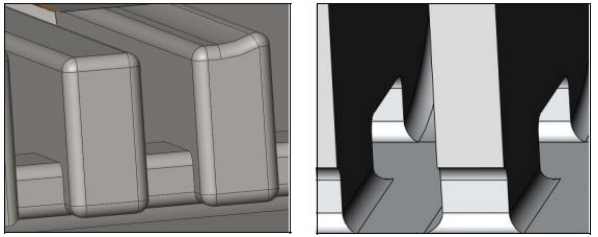
Figure 18. The fillets and powder outlets of SLM parts.